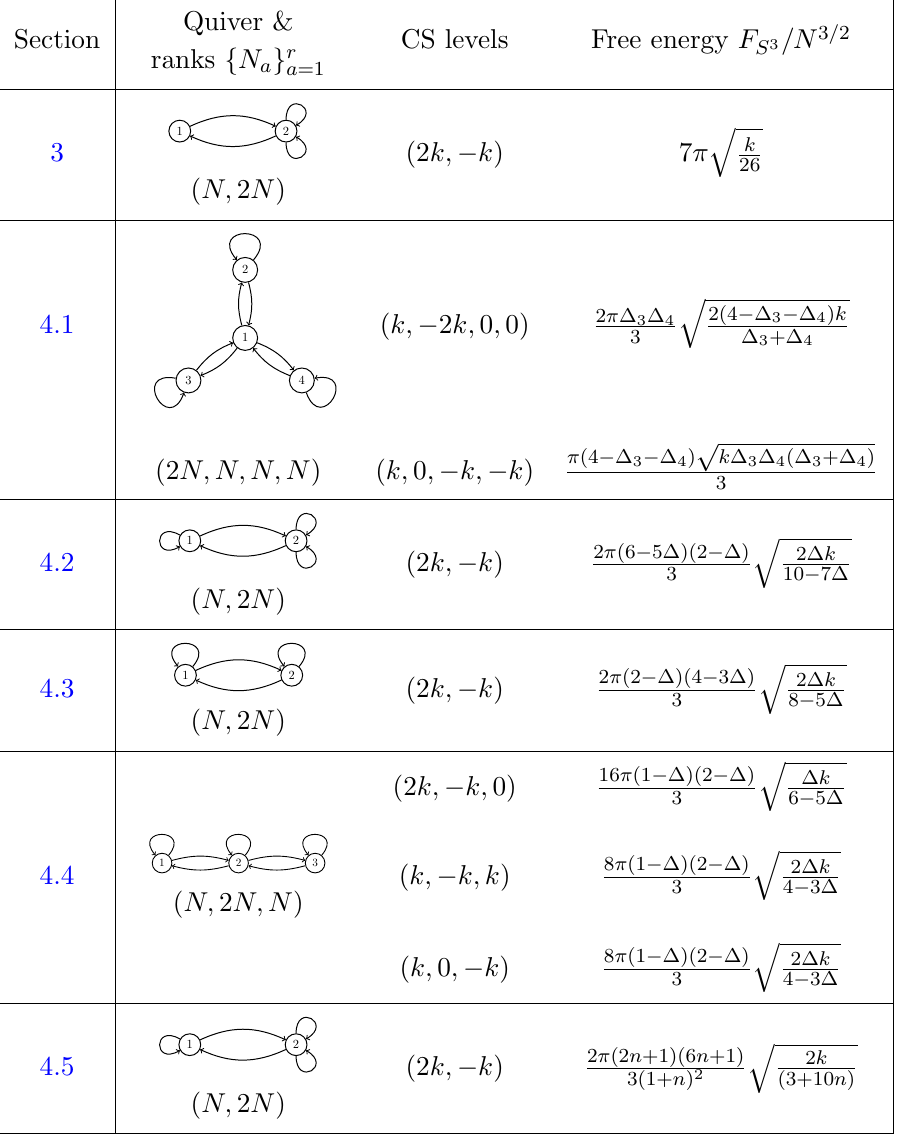
Table 1 . Summary of results for the new 3d N = 2 models introduced in the paper. We show the quiver, the di(cid:11)erent ranks N a (the progressive labeling of the nodes in the quiver is given by a ), the various CS assignments k a we considered such that P N a k a = 0, and (cid:12)nally the three-sphere a free energy exhibiting the N 3 = 2 scaling. The latter was obtained analytically by solving the matrix model according to the rules explained in section